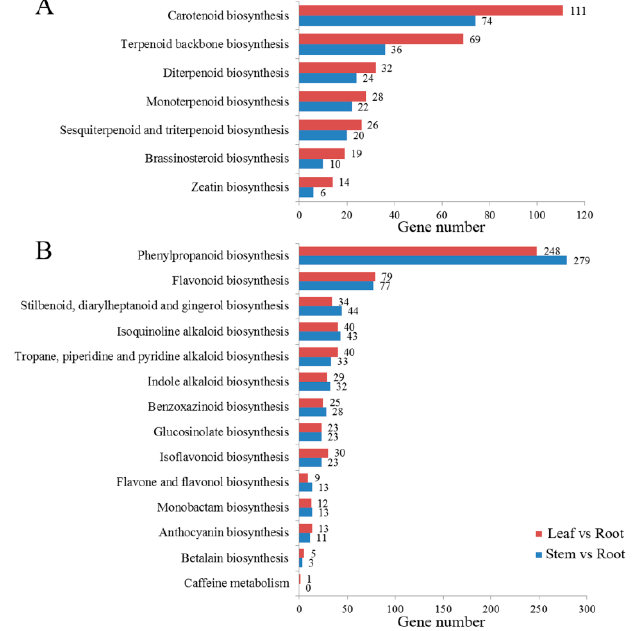
Figure 7. Number of DEGs in the most enriched pathways. ( A ) Number of upregulated DEGs in stem vs. root and leaf vs. root samples involved in terpenoid and polyketide metabolism. ( B ) Number of upregulated DEGs in stem vs. root and leaf vs. root samples involved in the biosynthesis of other secondary metabolites.